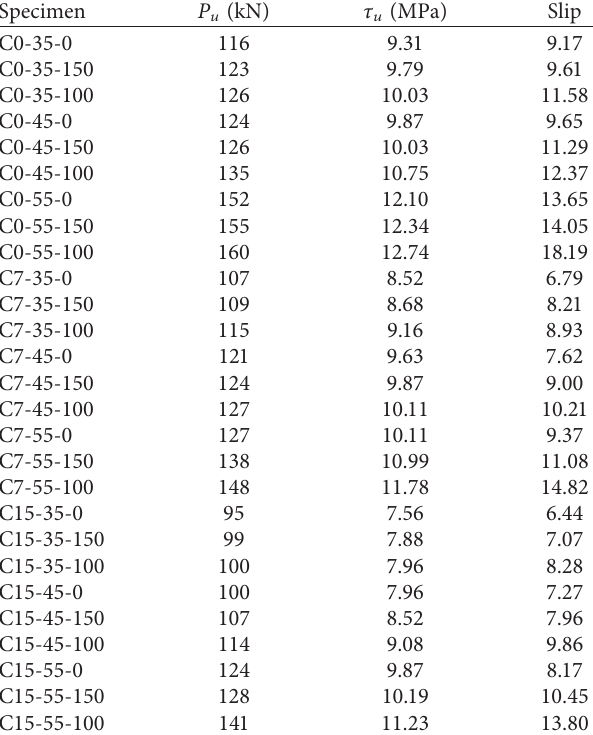
Figure 4: Loading apparatus and the layout of the measuring instrument: (a) the layout of the strain gauge; (b) waterproofing treatment of reinforcement; (c) the schematic view of the loading apparatus; and (d) the loading test in site. Table 3: The measuring results of experimental